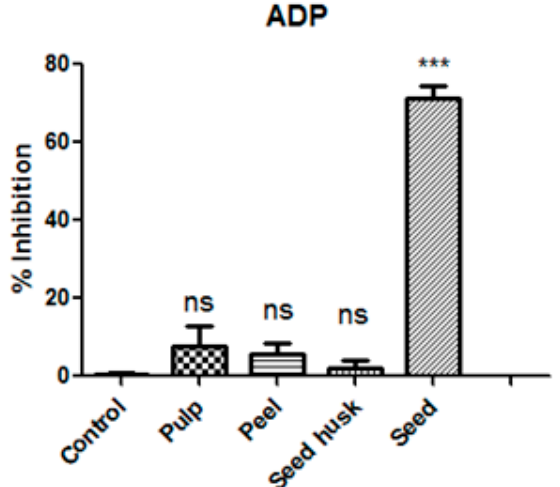
Figure 1. Antiplatelet aggregation activity results of extracts from mango and its by-products (peel, seed husk and seed) at 1.0 mg/mL against adenosine 5’-diphosphate (ADP) agonist (4 µM) expressed as mean value of inhibition percentages ( n = 6). Data was analyzed using ANOVA of one factor. Post hoc analyses were conducted using Tukey’s test. *** denotes significant differences compared to the negative control (absence of extract) at p = 0.001; ns denotes no statistical differences.